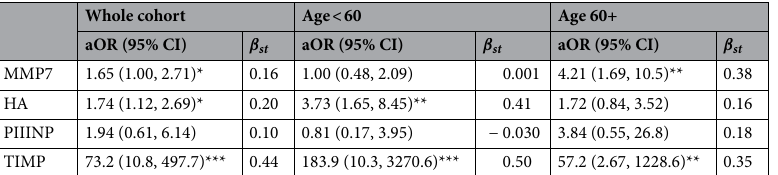
Table 5. Standardised coefficients of serum biomarkers for the prediction of clinically significant fibrosis (LSM ≥ 8.2) using multivariable logistic regression models by age above or below 60. All biomarker concentrations in natural log. *p < 0.05, **p < 0.01, ***p <